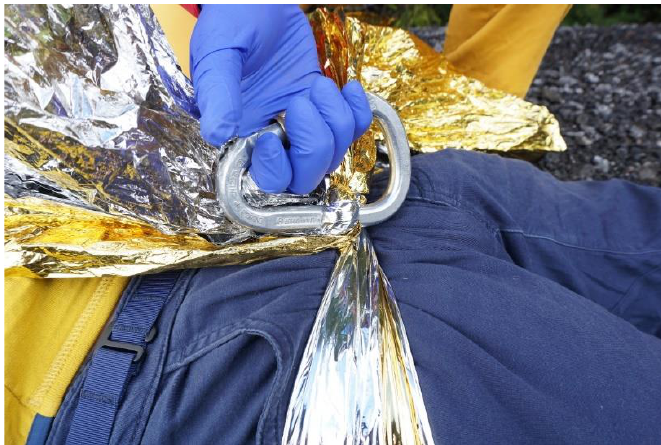
Figure 4. Application of a rescue blanket as pelvic sling/pelvic binder.